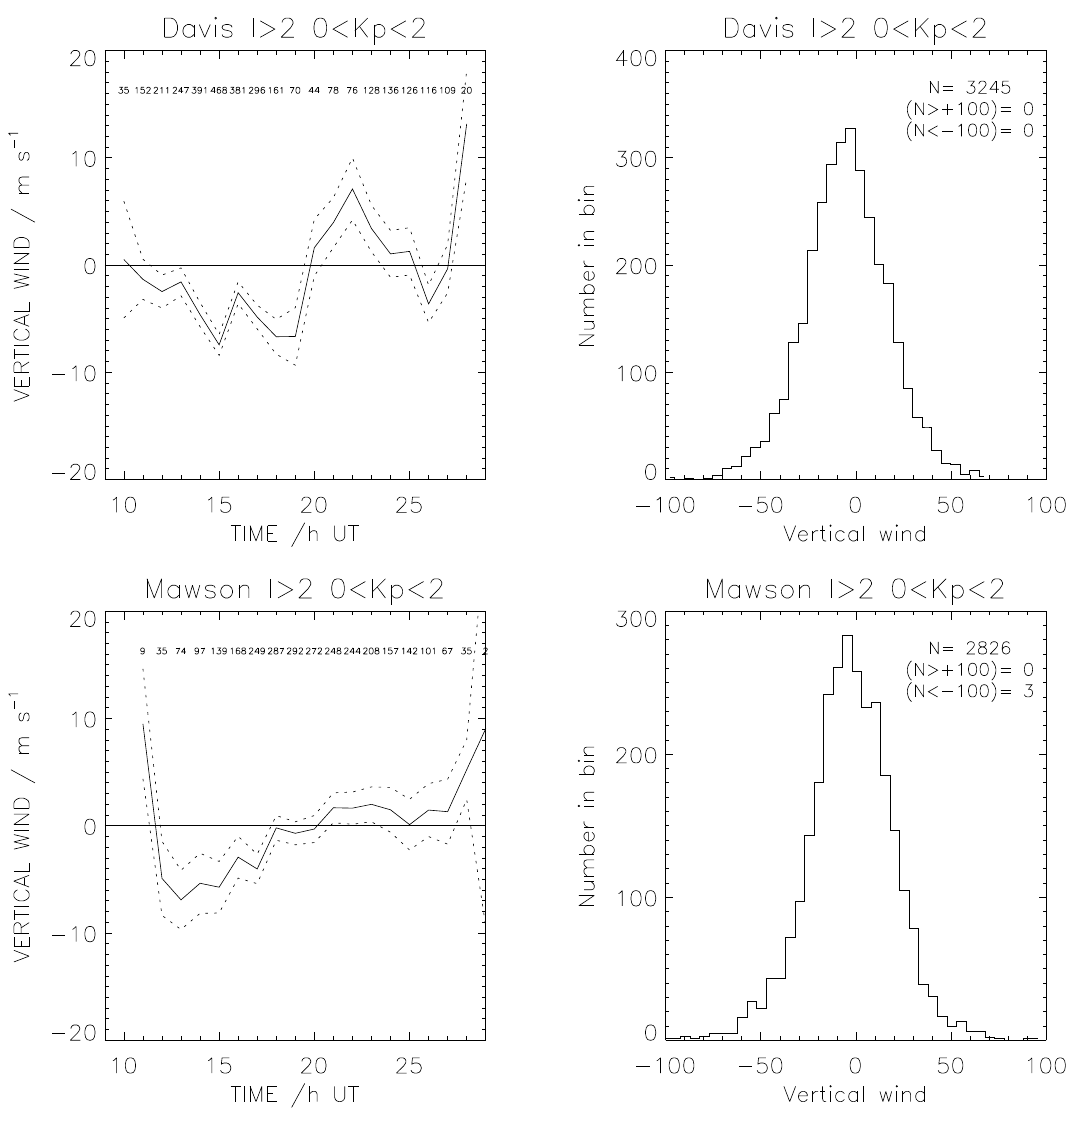
Fig. 8. Hourly mean vertical winds and histograms for high intensity, low K p , measurements from Davis and Mawson. As in Fig. 4 the total number and outliers are given. The majority of these measurements would be from the auroral oval.